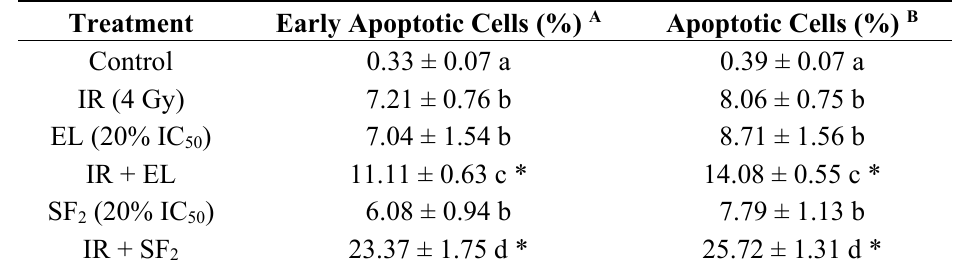
Table 2. The radiosensitivity effects of different treatments on apoptosis in A549 cells.